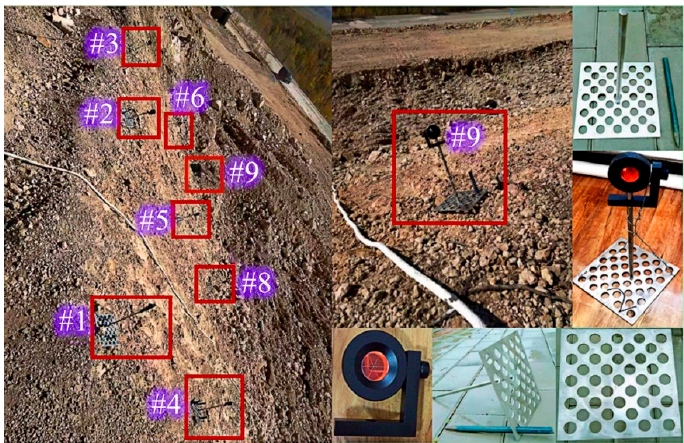
Figure 14. Landmarks placed on the first-grade slope.